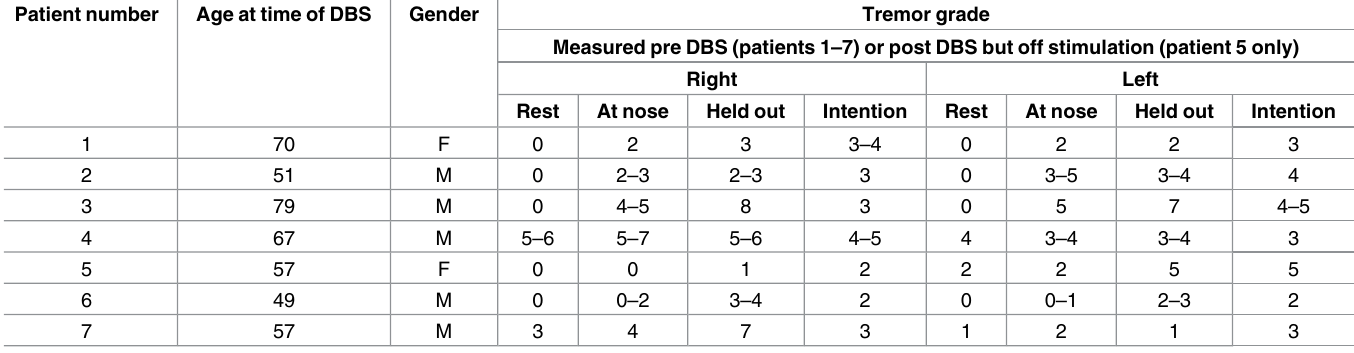
Table 1. Table of patient details. The patient detailsfor the seven patients with ET who underwentDBS surgery and whose local field potentialdata was used in the study. We includeage at time of DBS surgery, genderand tremor gradingscores for right and left arms in four positions:rest, held at nose, held outstretchedand whilst making a reachingmovement (intention).All signalswere down sampledto a samplingfrequencyof 64 Hz. The power spectra of the filtered LFP signalswere obtained using a Fourier transform (fft function in Matlab). Cross-coherencewas performed betweenthe LFP and EMG signals (mscoherefunction in Matlab, Mathworks), using a periodicHamming window, with the number of steps set to 32 and 50% overlap. Spectra were averaged across electrodesand sides of the brain and then across patients for each condition. The results obtainedfrom this data analysiswere used to constrain the behaviour of the computational model, by comparing the peak frequency of the cross-coherence to the frequencyof oscillationsproducedby the model. Patient number Age at time of DBS